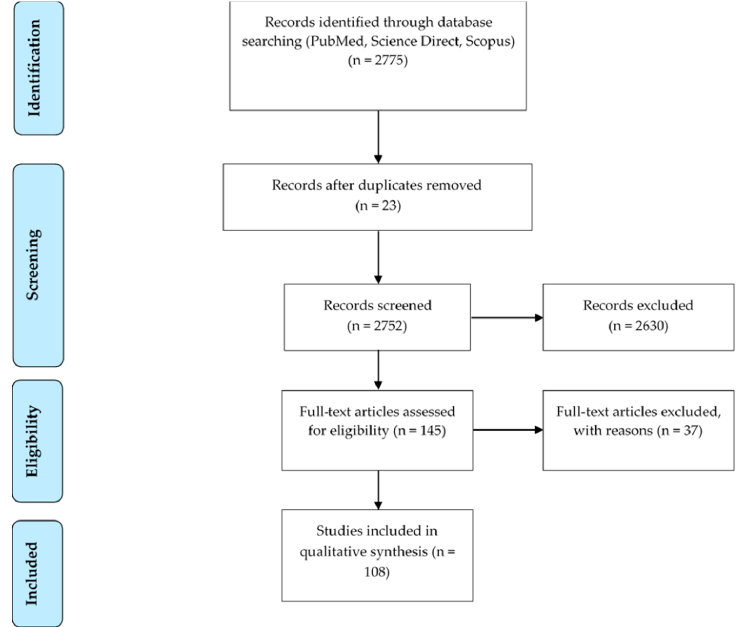
Figure 1. Flow diagram summarizing the search strategy.